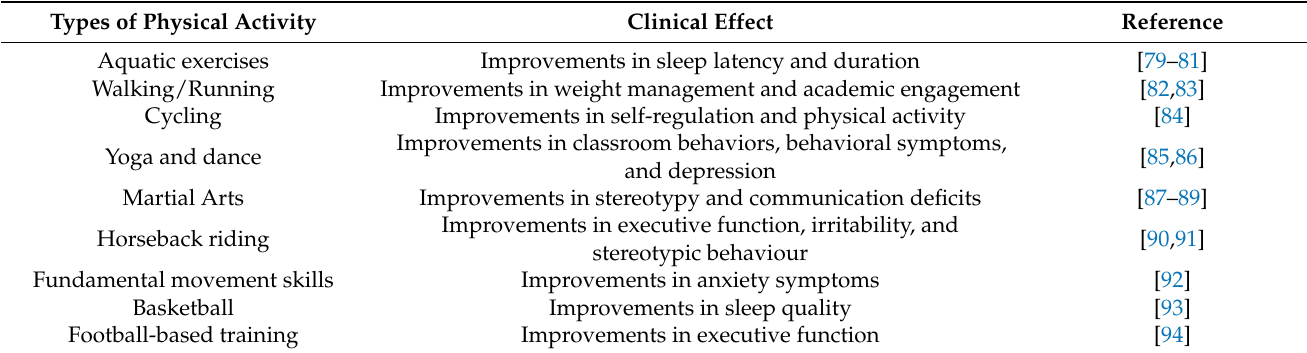
Table 1. Clinical effects of physical activity in children and adolescents with